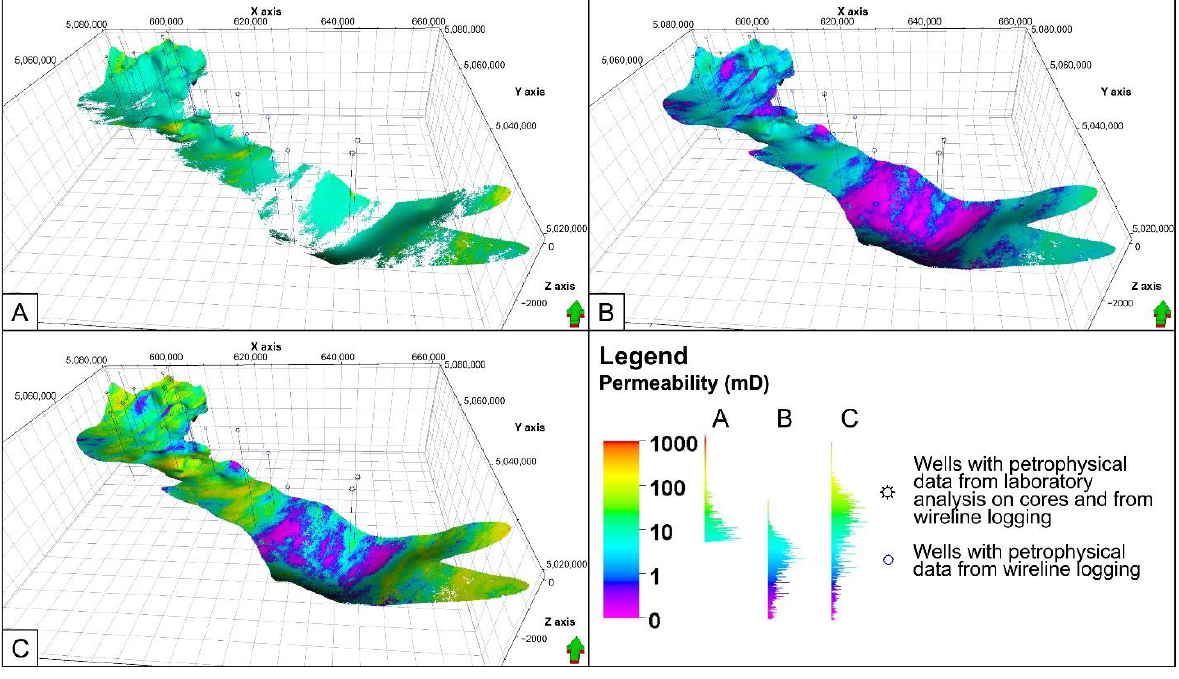
Figure 7. Permeability models of the DSA Poljana: ( A ) calculated from the relationship shown in Figure 4 with an 18% porosity cut-off, ( B ) calculated based on the Slichter equation in [61], and ( C ) calculated based on the Timur equation in